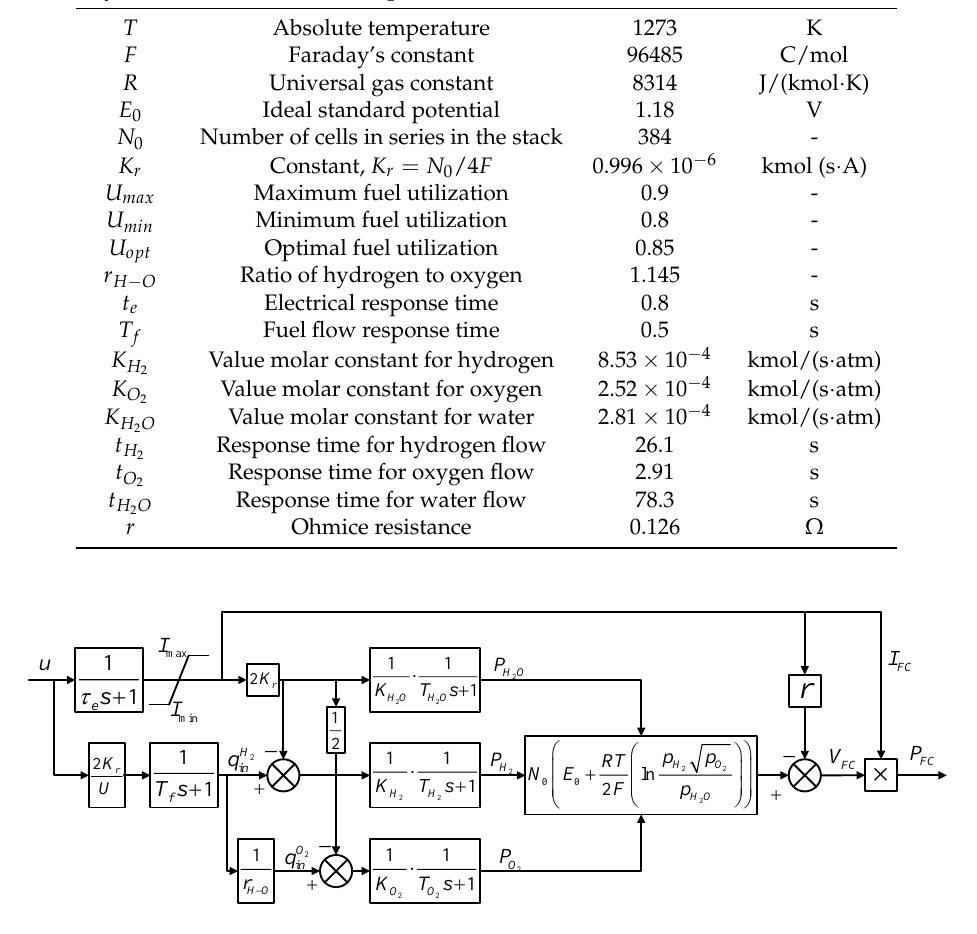
Figure 2. Fuel Cell